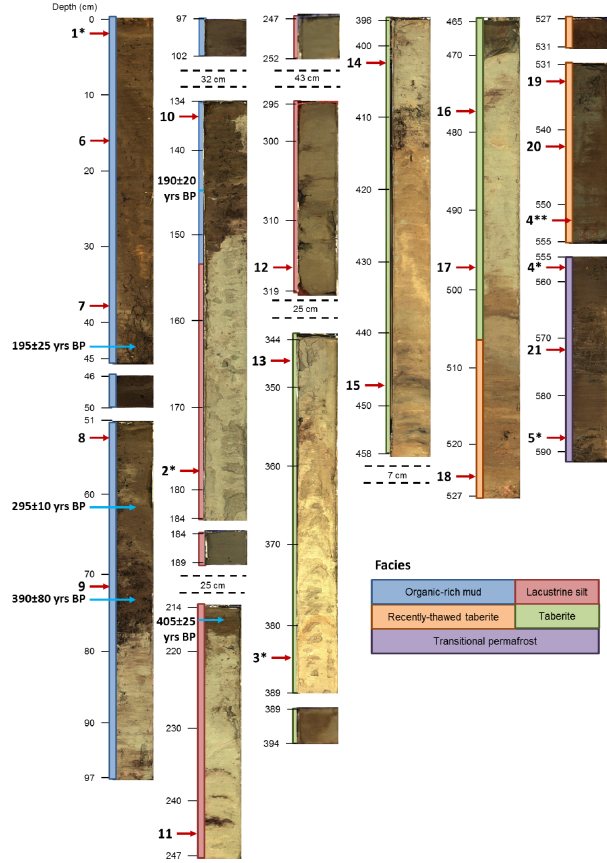
Figure 2. The Vault Lake core with the five facies (Organic-rich mud, Lacustrine silt, Taberite, Recently thawed taberite, and Transi- tional permafrost) delineated. Core depth values are indicated; core subsampling locations for incubations are marked using red arrows with bold numbers indicating incubation sample IDs; locations of picked and 14 C dated macrofossil are shown by blue arrows and calibrated 14 C ages (calendar years BP). Labeled breaks represent gaps in the sediment